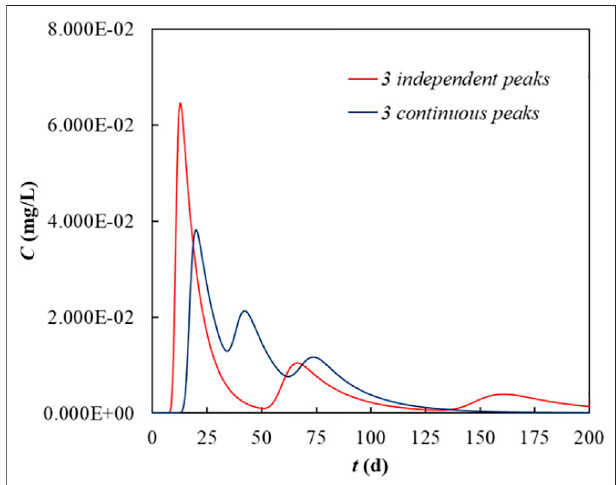
FIGURE 16 | Tracer output curve of interwell multicavity in parallel under different